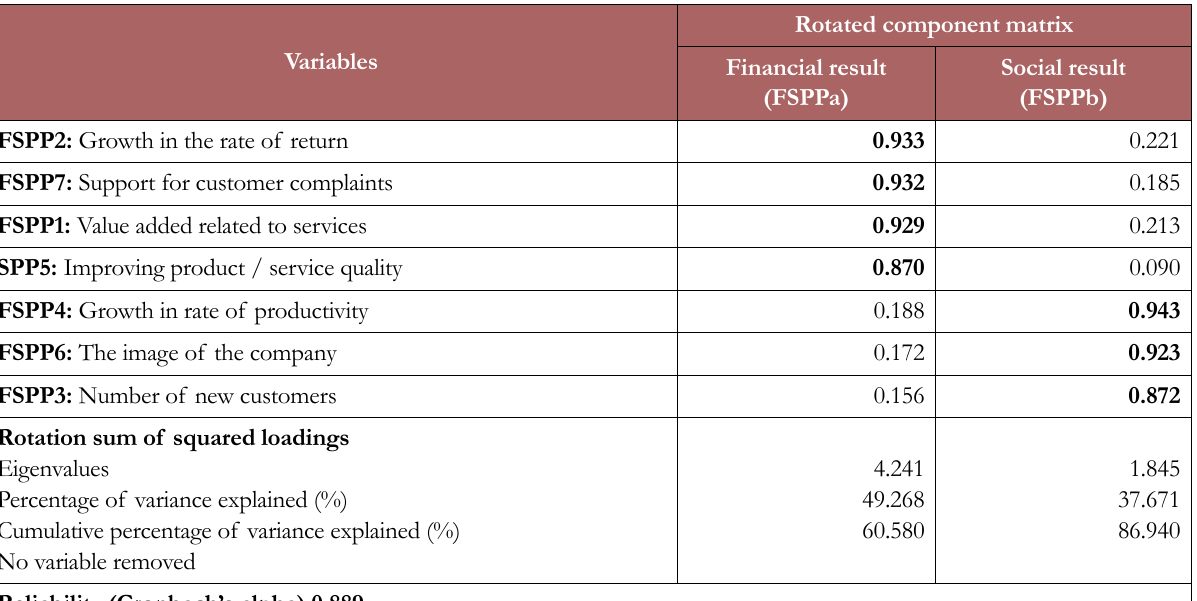
Table 12. EFA of the FSPP